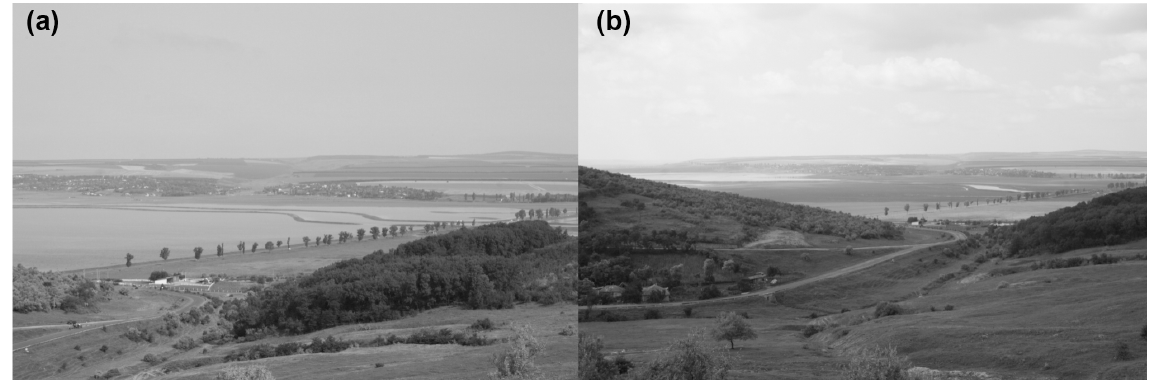
Figure 11. Polders on the Jijia and the floods recorded in the summer of 2010: storage of excess water (left) and its elimination (right).